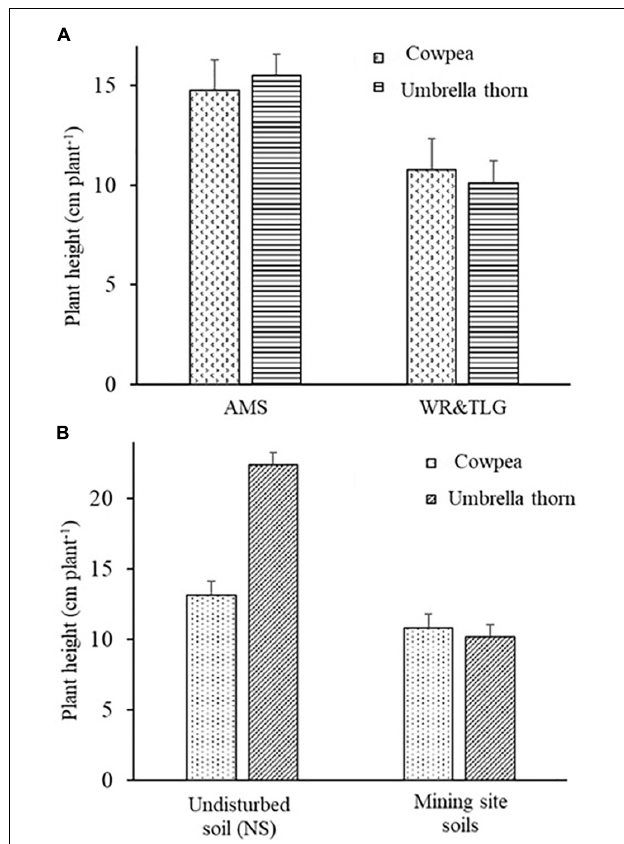
FIGURE 4 | Umbrella thorn and cowpea height growth responses to contrasting soil types in the greenhouse: Soils of the artisanal mining site (AMS) vs soils of the conventional mining site (A) ; Undisturbed-natural soil (NS) vs mine site soils (B) . Error bars represent the standard errors of means.